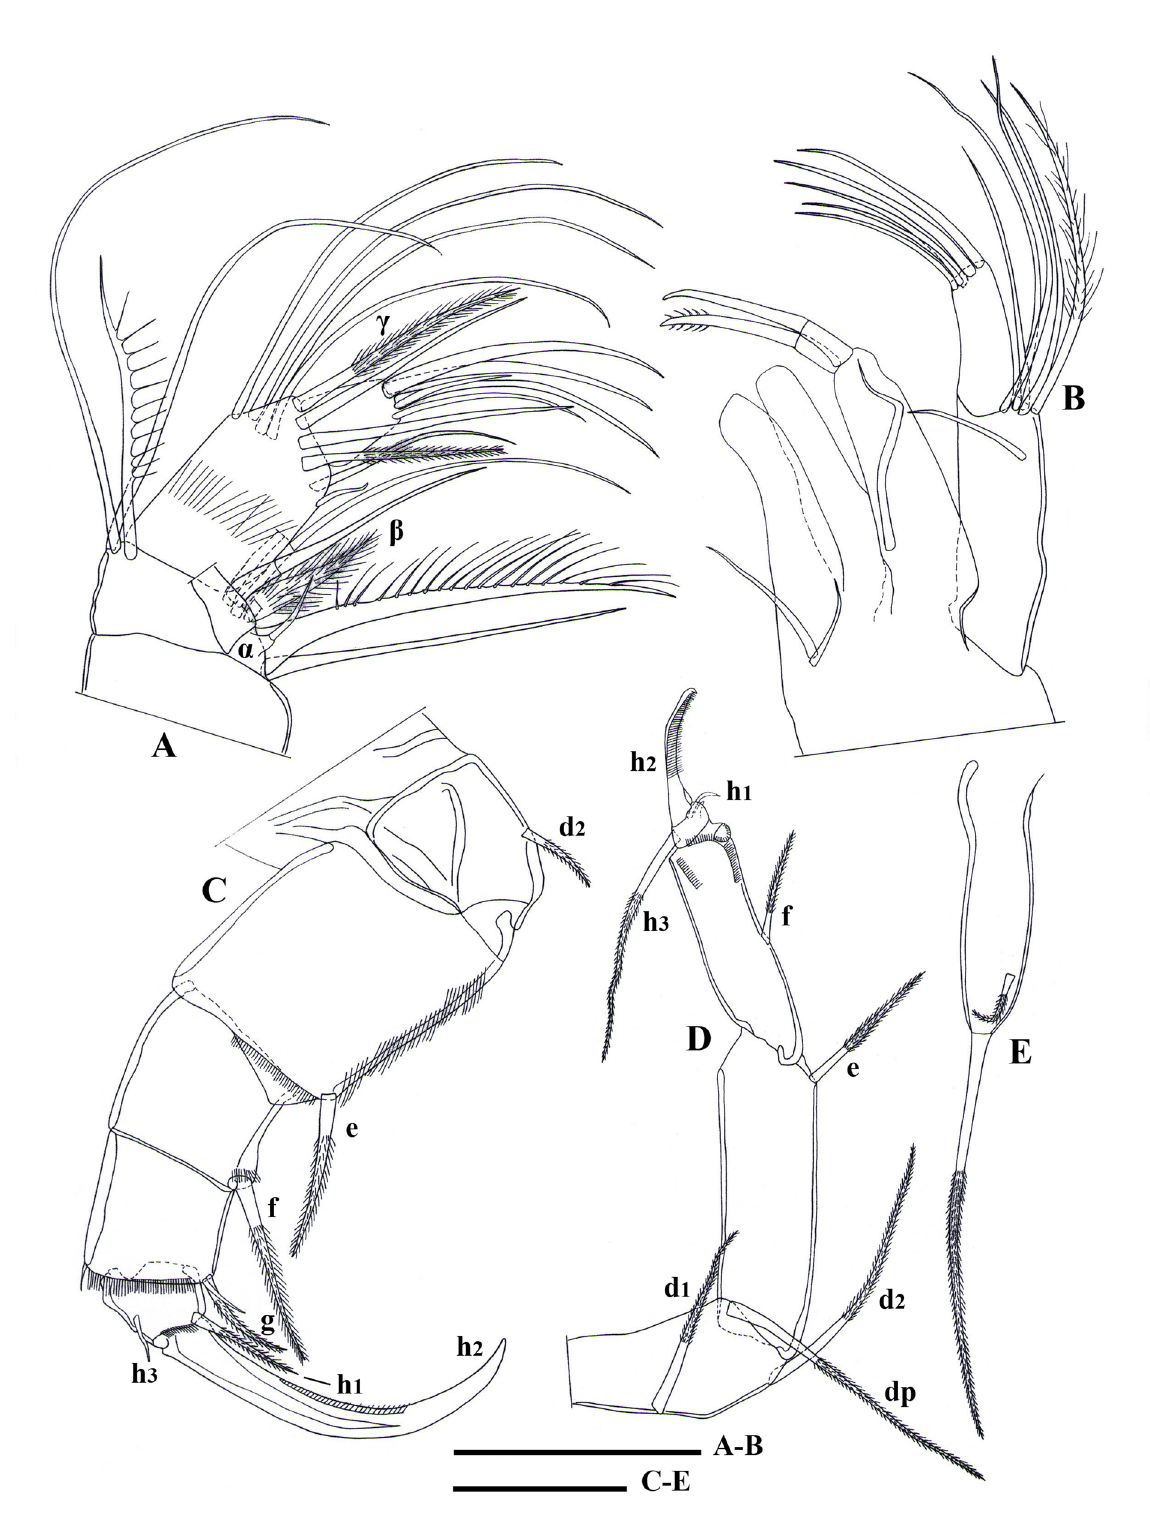
Fig. 10. Siamopsis conspecta gen. et sp. nov., ♀ (MSU-ZOC.201). A . Md palp. B . Mx1. C . T2. D . T3. E . CR. Scale bars: 50